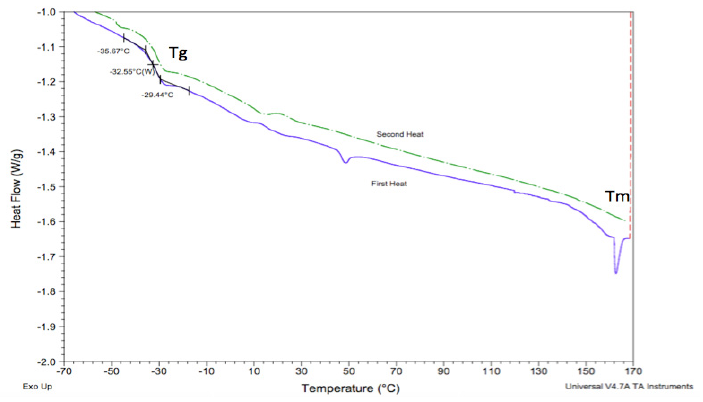
Figure 4. Differential Scanning Calorimetric (DSC) analysis of PHA polymer synthesized by P.